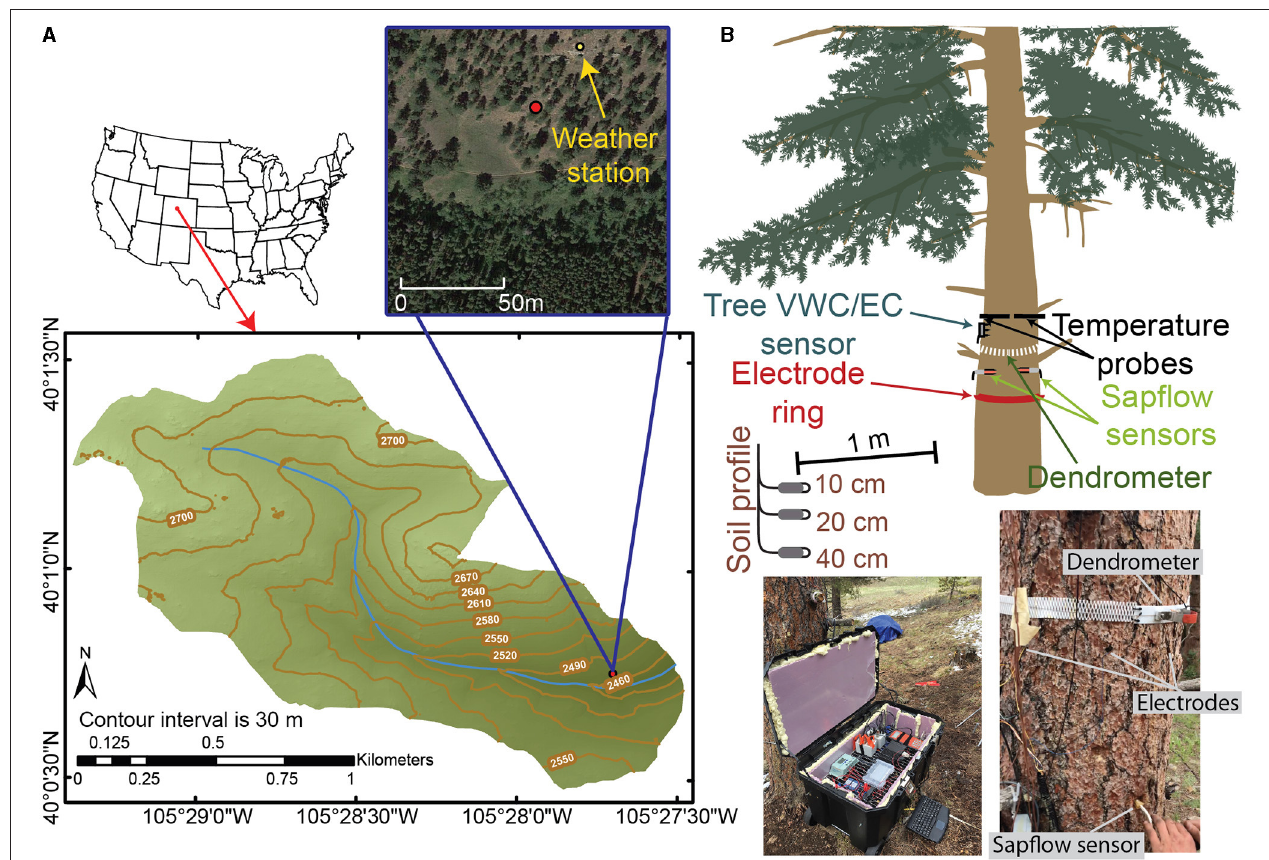
FIGURE 1 | (A) Map of the Gordon Gulch watershed with an aerial image of the location of our study tree (red dot). (B) A schematic of the study tree and the locations of the various instruments installed and pictures showing some of the